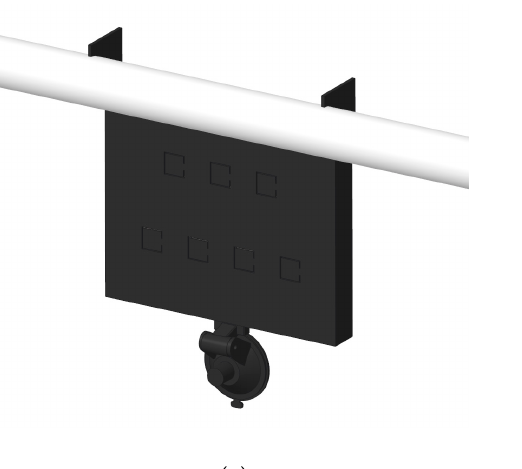
Figure 6. Application of the IoT device as an add ‐ on module: ( a ) CAD representation; ( b ) real im ‐ plementation with labels over the cantilever ‐ like buttons that replicate the original control panel.